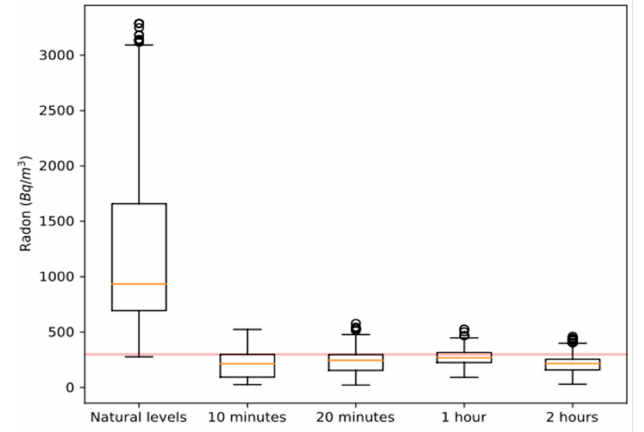
Figure 6. Comparison between the natural radon concentration and the concentration during the test for each interpolation time window (each test lasted one week, and the natural concentration was measured during one week).